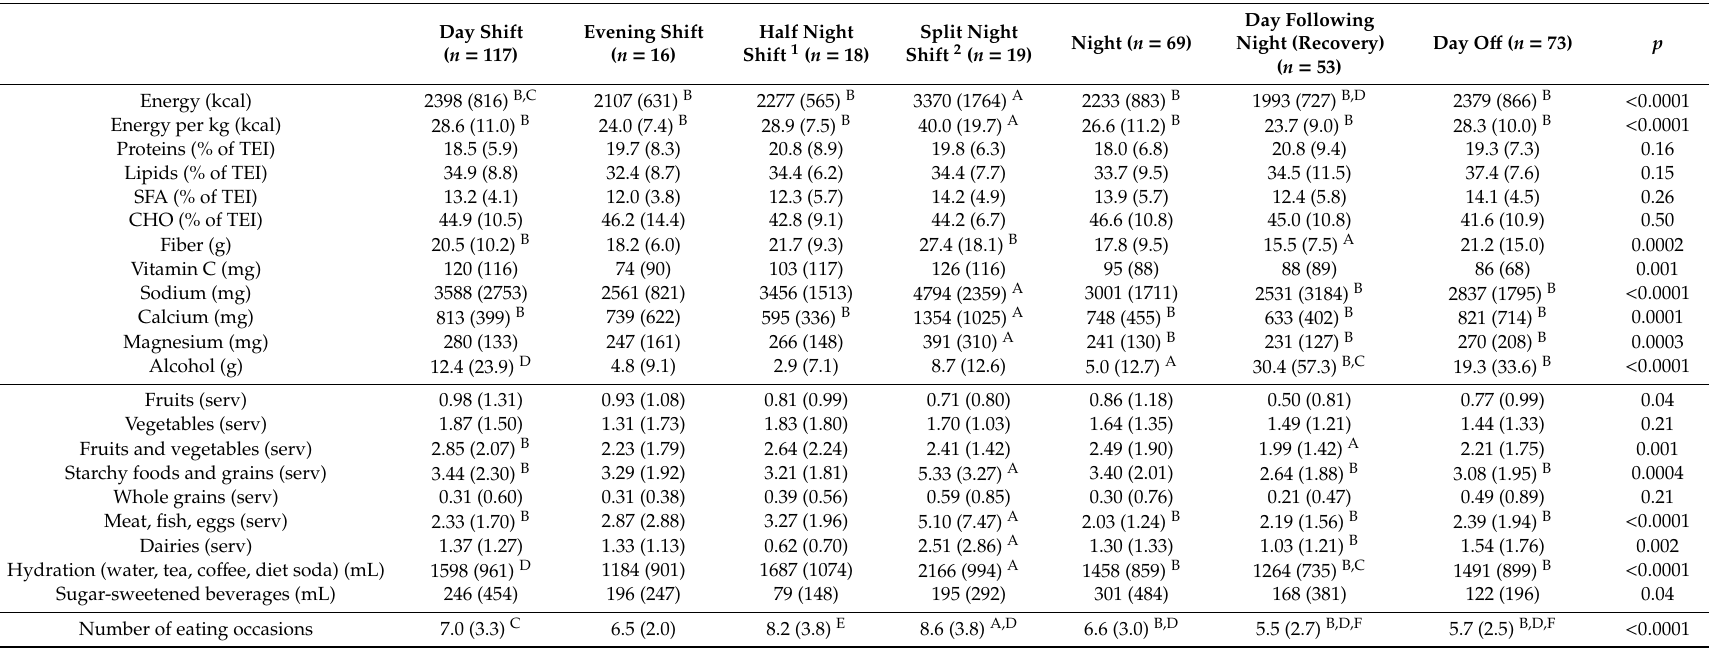
Table 3. Mean intakes (SD) of energy, nutrients and food groups of shift workers during di ff erent schedule